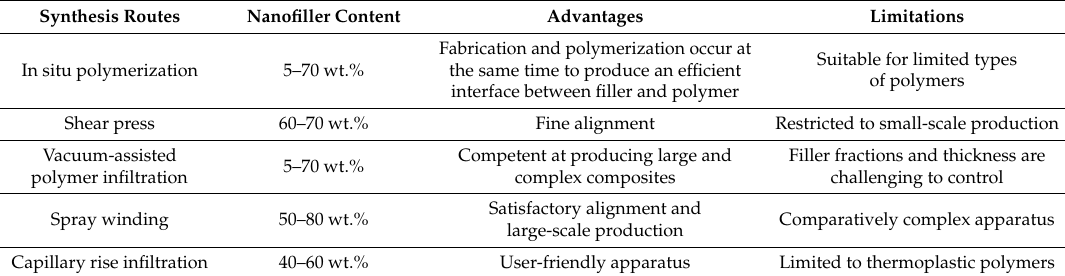
Table 3. Advantages and disadvantages of nanocomposites synthesis routes